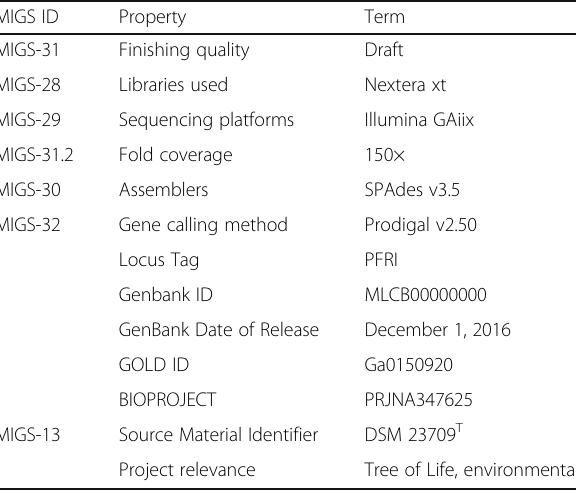
Table 2 Project